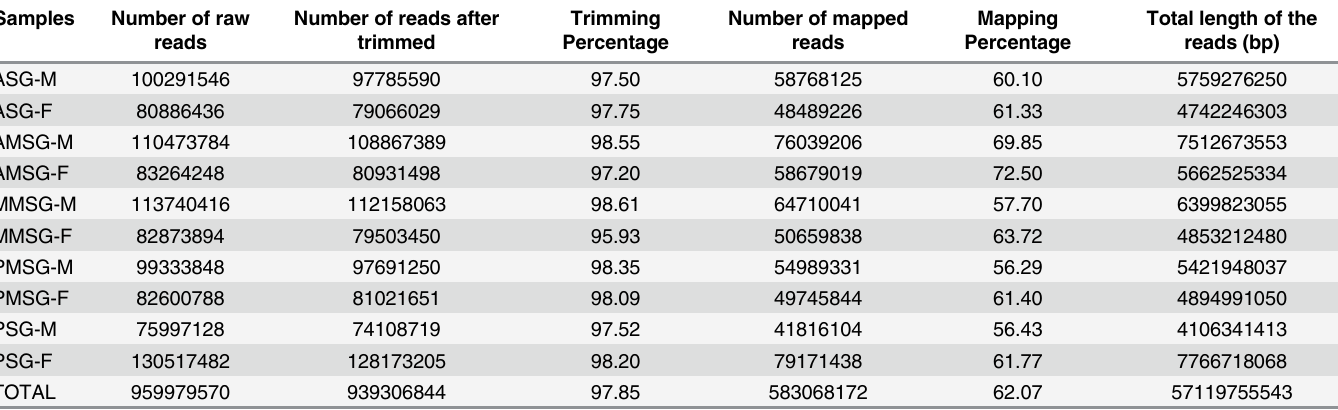
Table 1. RNA-Seq data of different parts of the silk